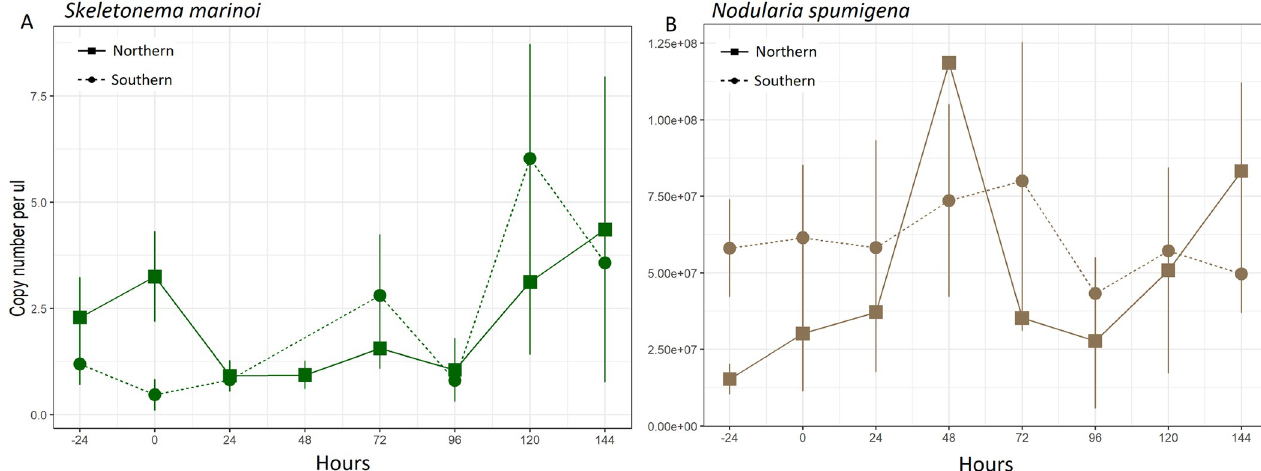
Fig 2. Phytoplankton consumed by Macoma balthica determined by qPCR assays. Phytoplankton consumption by M . balthica , determined by qPCR and reported in number of copies μ L -1 (16S rRNA gene for Nodularia spumigena and 18S rRNA gene for Skeletonema marinoi ). Panel A represents consumption of the diatom S . marinoi (green), while B represents the cyanobacteria N . spumigena (brown). Squares and solid lines represent the northern Stockholm archipelago clams, and circles and dotted lines represent the southern Stockholm archipelago clams. Error bars represent standard error.